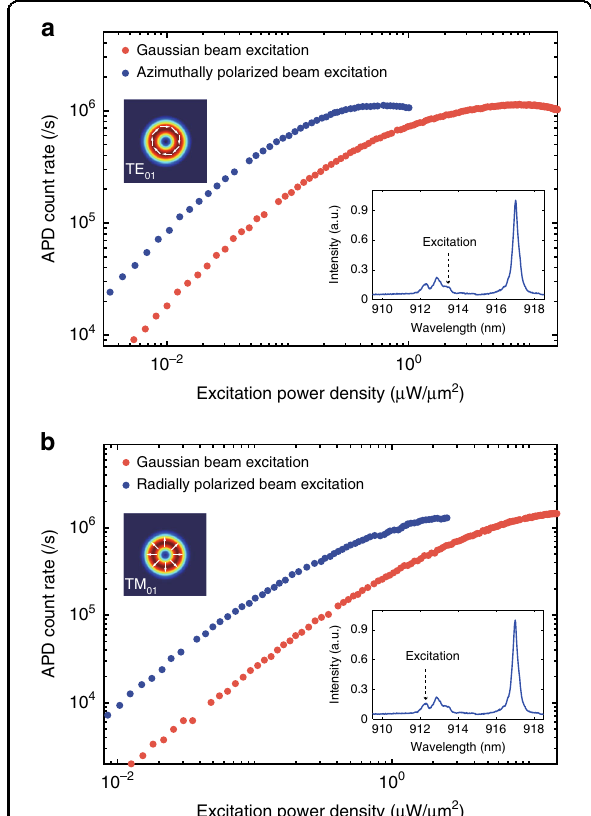
Fig. 5 Power dependence of QD emission excited by vectorial beams. The CX is resonant with HE 11 mode, and excited via the azimuthally polarized TE 01 mode (blue) ( a ) and the radially polarized TM 01 mode (blue) ( b ) to match the polarization states of the high- order cavity modes. For comparison, a linear polarized Gaussian beam excitation (red) is